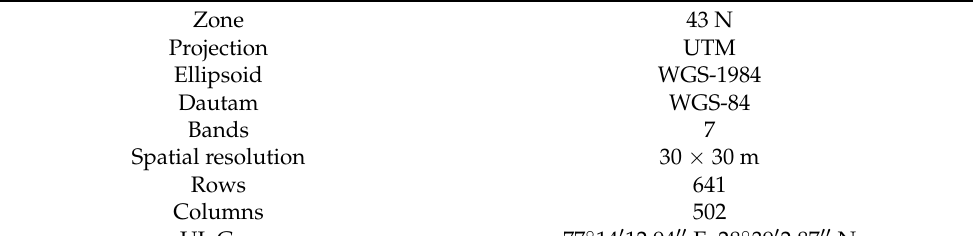
Table 1. Description of data.